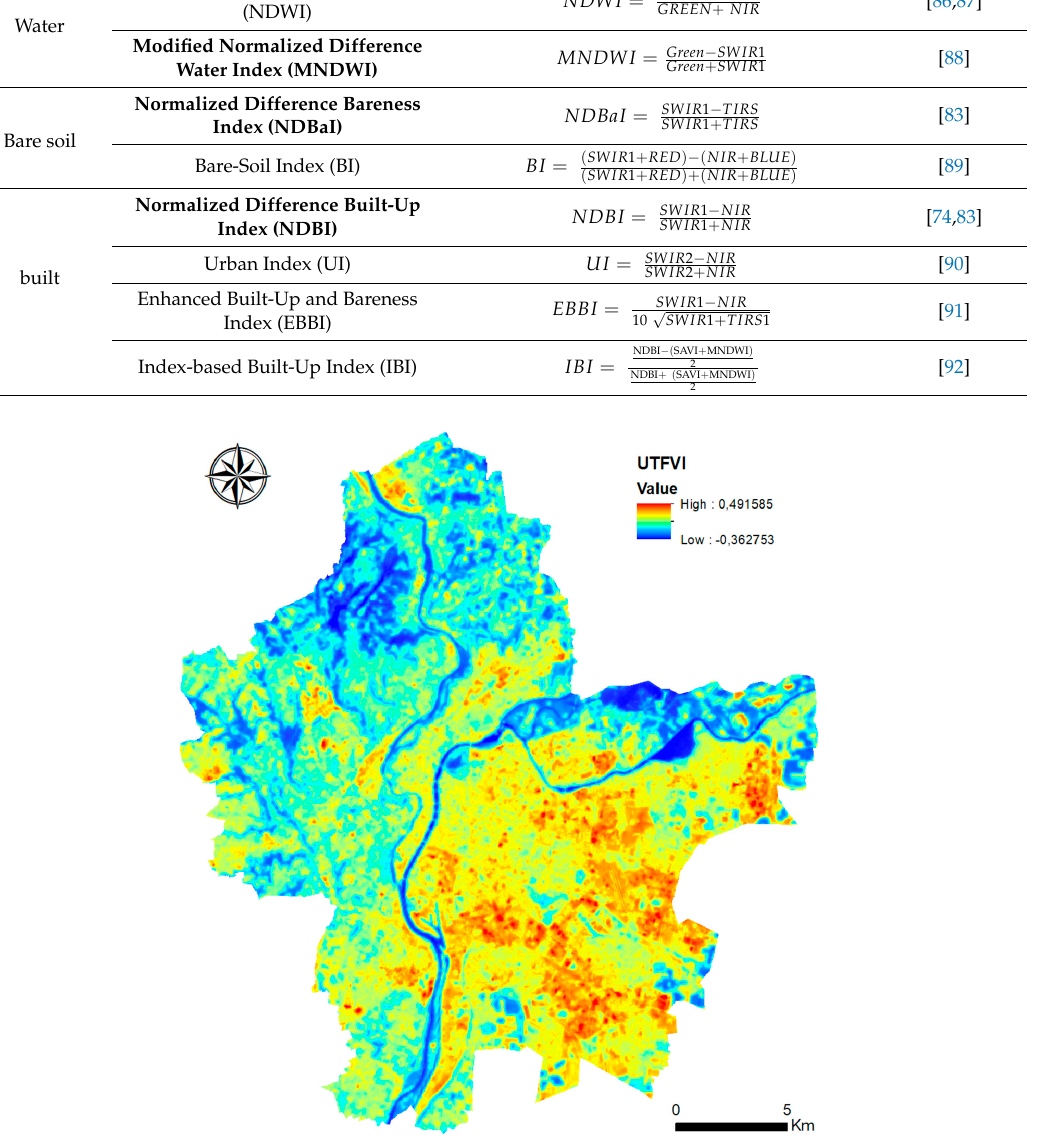
Table 4. Threshold values of the Urban Thermal Field Variance Index (UTFVI) and ecological evaluation index (source: Reference [42]).